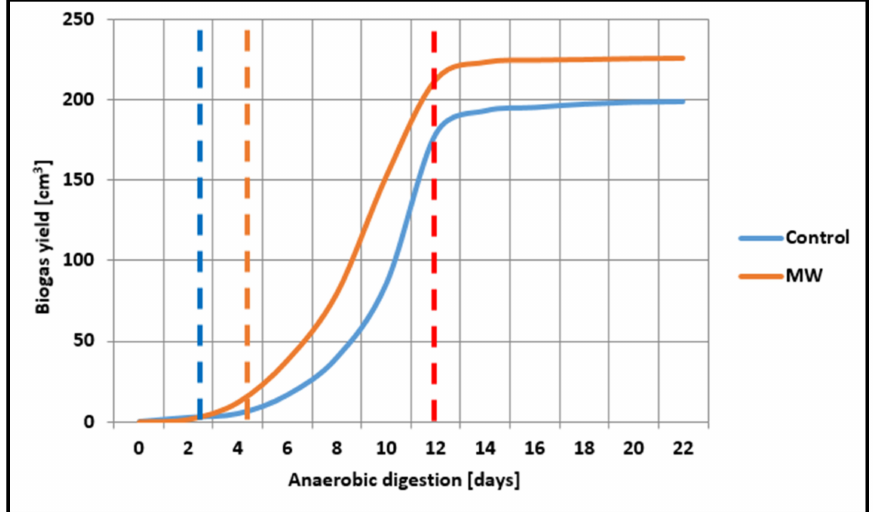
Figure 7. Accumulating biogas volume during AD (note: the term biogas yield refers to the cumula- tive biogas volume/biogas product during the